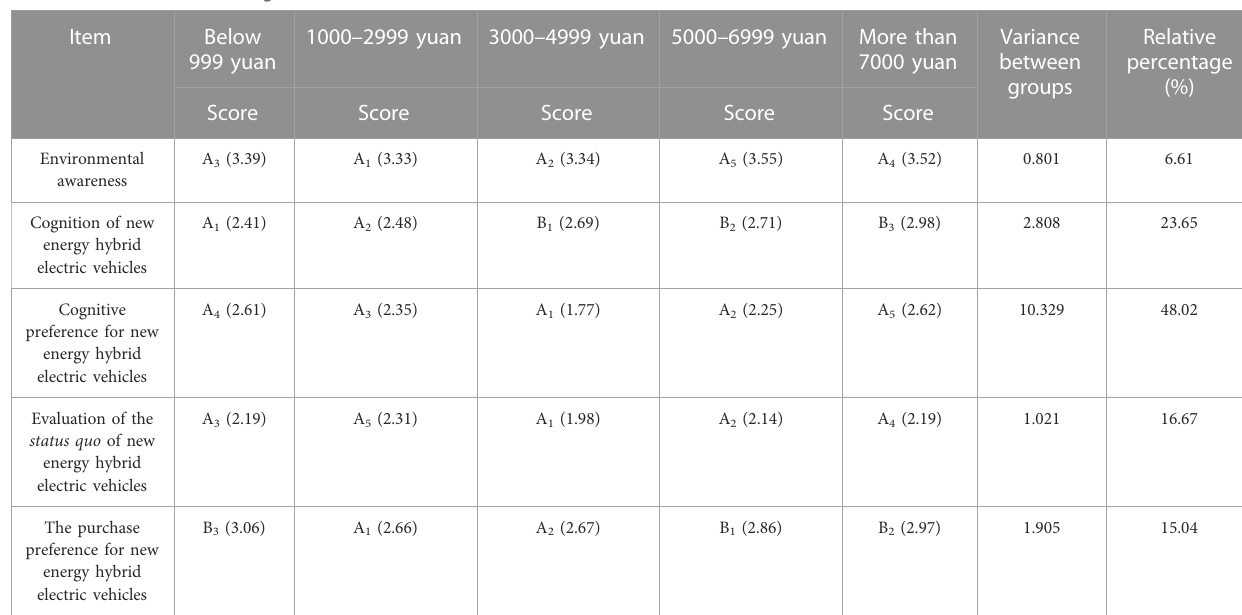
TABLE 9 Test results and ranking of different income